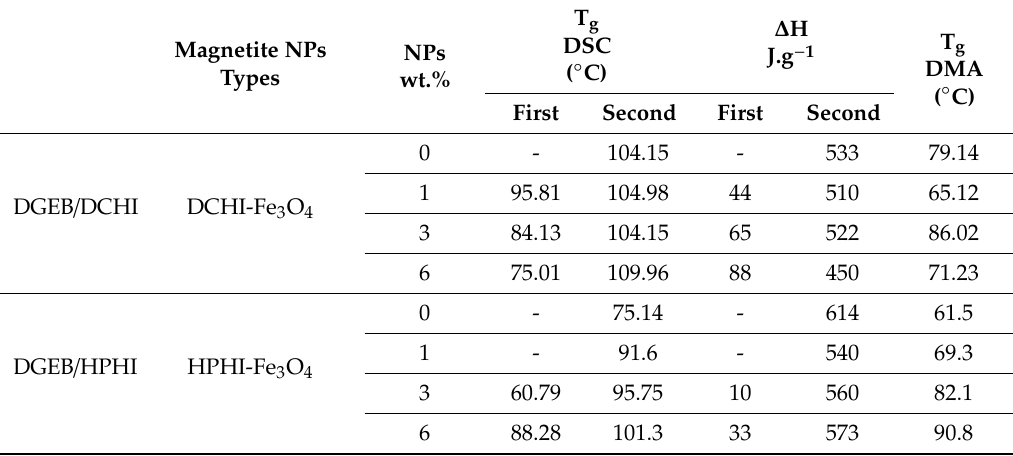
Table 3. Di ff erential scanning calorimetry (DSC) and dynamic mechanical thermal analyzer (DMA) data of DGEB / DCHI and DGEB / HPHI systems in the absence or presence of HPHI-Fe 3 O 4 and DCHI-Fe 3 O 4 nanoparticles (NPs).